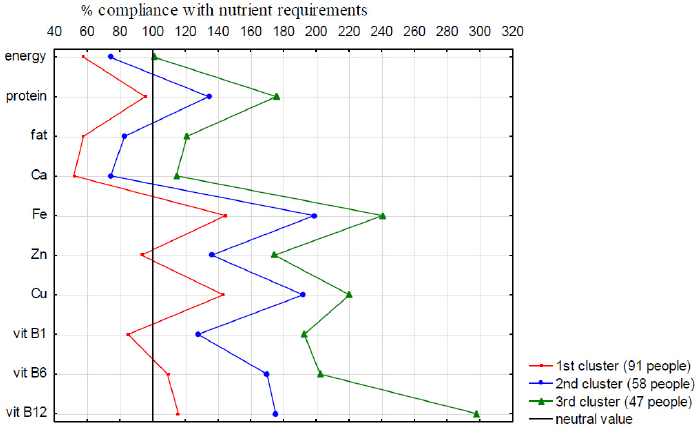
Figure 1. Division of the respondents into clusters, by the Kohonen’s neural